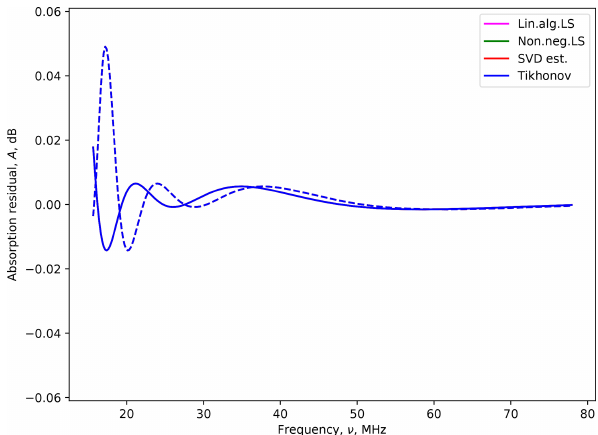
Figure 8. Application of the forward models to different solutions. The black “nominal” line does not readily appear as the “estimate” is collinear with it. The horizontal axis is the observing radio fre- quency, ν = ω/ 2 π .